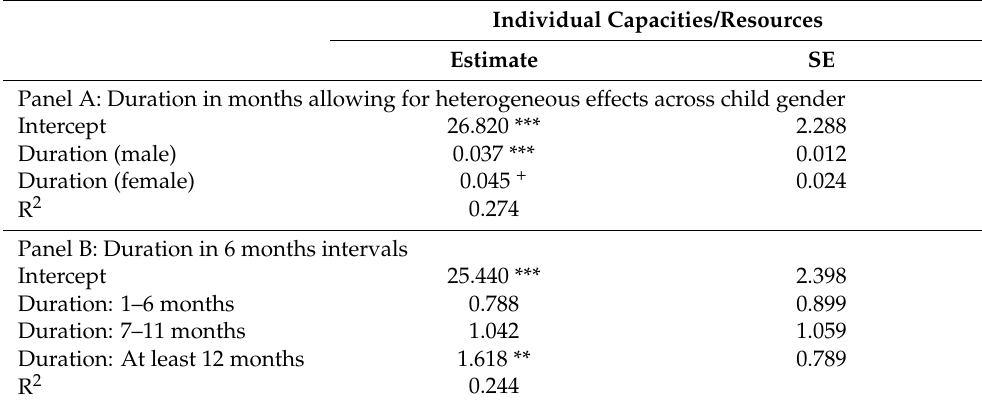
Table 4. Results of Ordinary Least-Squares Regression of CYRM Individual Capacities/Resources Subscale on Duration of Friendship. Individual Capacities/Resources Estimate SE 26.820 ***